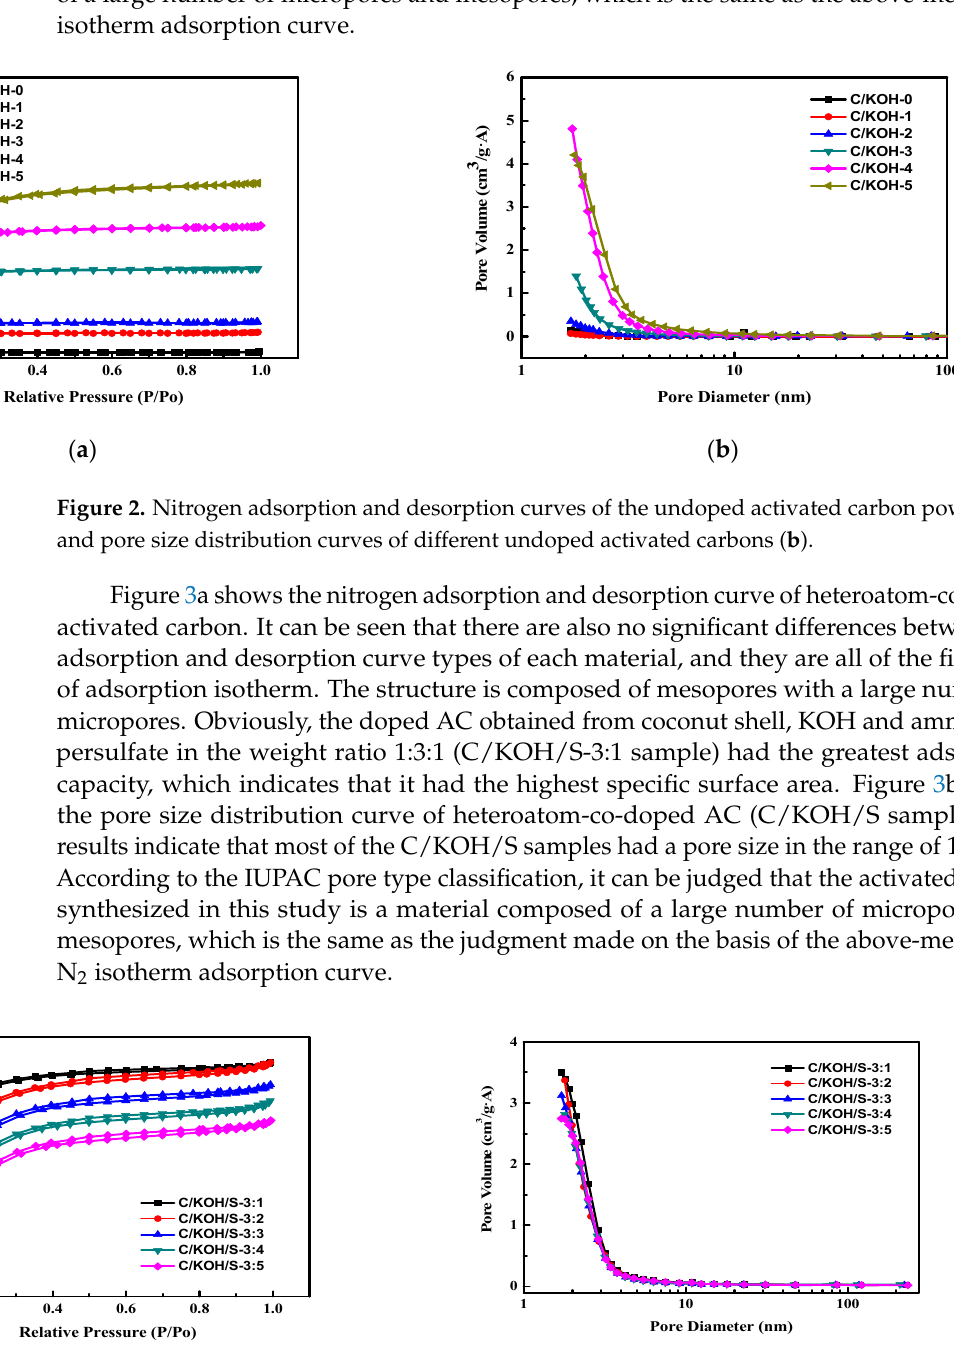
( f ) Figure 1. SEM image of coconut shell after activation with KOH at 700 °C: ( a ) C/KOH-0, ( b ) C/KOH- 1, ( c ) C/KOH-2, ( d ) C/KOH-3, ( e ) C/KOH-4 and ( f ) C/KOH-5. This study used a BET specific surface to analyze the AC obtained using coconut shell biomass as raw material. Figure 2a shows the nitrogen adsorption and desorption curve of the undoped activated carbon powders. It can be observed that there is no significant difference between the adsorption and desorption curve types for each material. They are all of the first type of adsorption isotherm. The adsorption isotherm increases rapidly at a lower relative pressure. After reaching a certain relative pressure, the adsorption satura- tion value appears, which is formed by a structure consisting of mesopores with a large number of micropores [72]. The adsorption capacity of activated carbon obtained at a